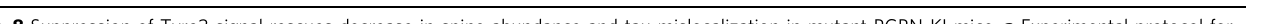
(Figs. 8, 9, and 10). B-Raf inhibitor suppressed tau phosphor- ylation at Ser203, but not at Thr220 (Fig. 6e). Tau phosphorylated